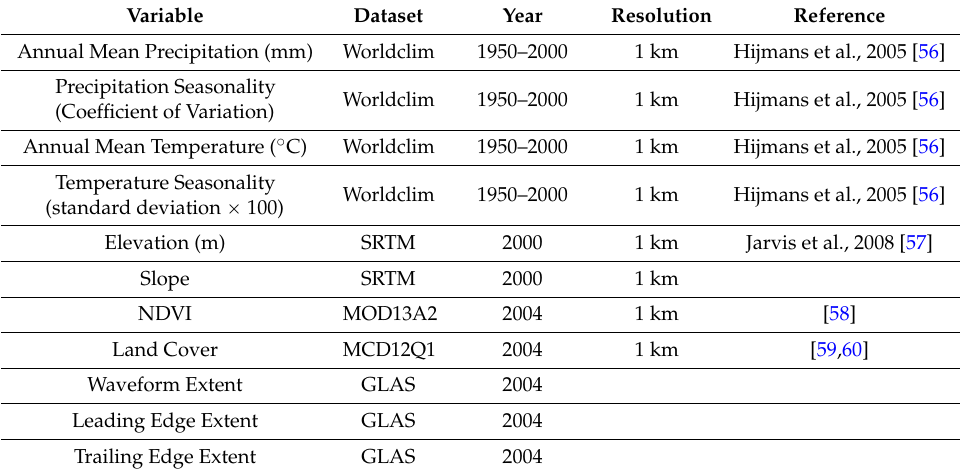
Table 1. Variables used in the random forest method to model aboveground biomass of